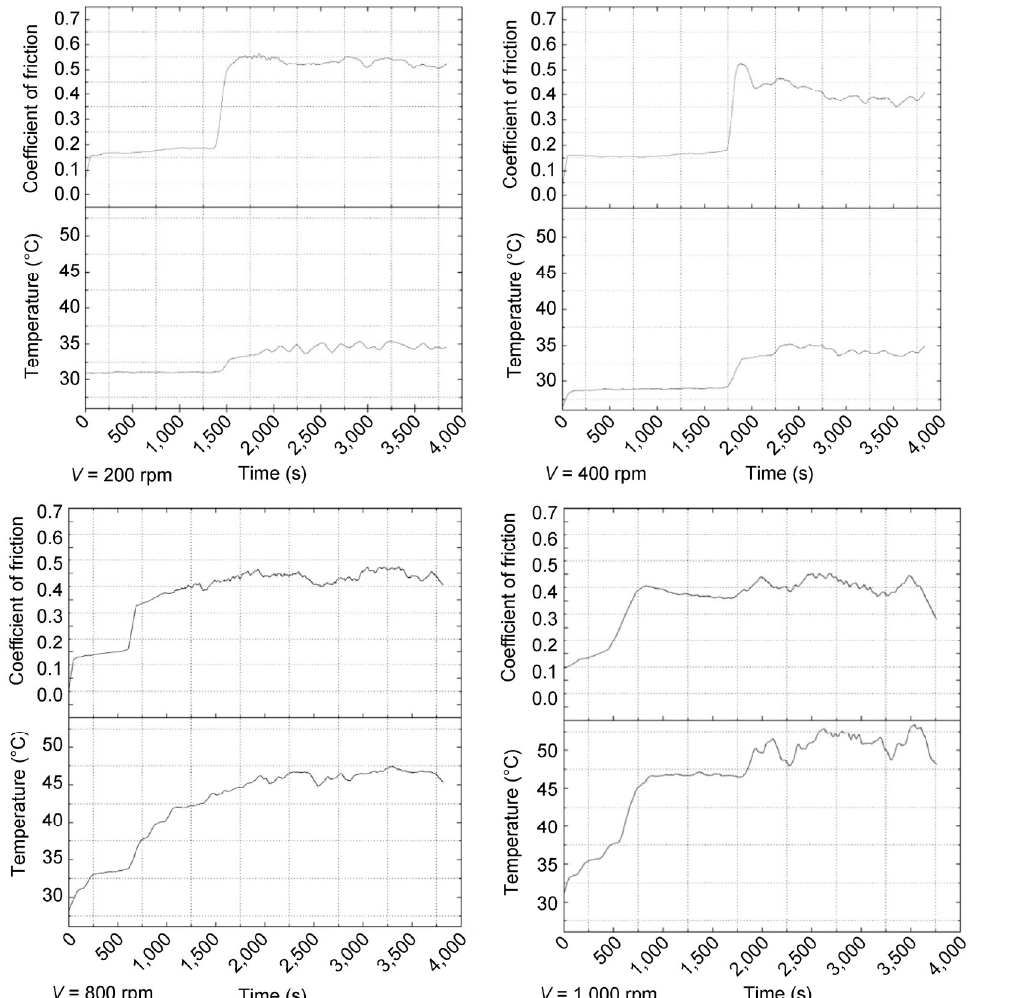
Fig. 4 Correlation between the coefficient of friction and temperature for the Ep-CNT samples at F n = 8 N and different